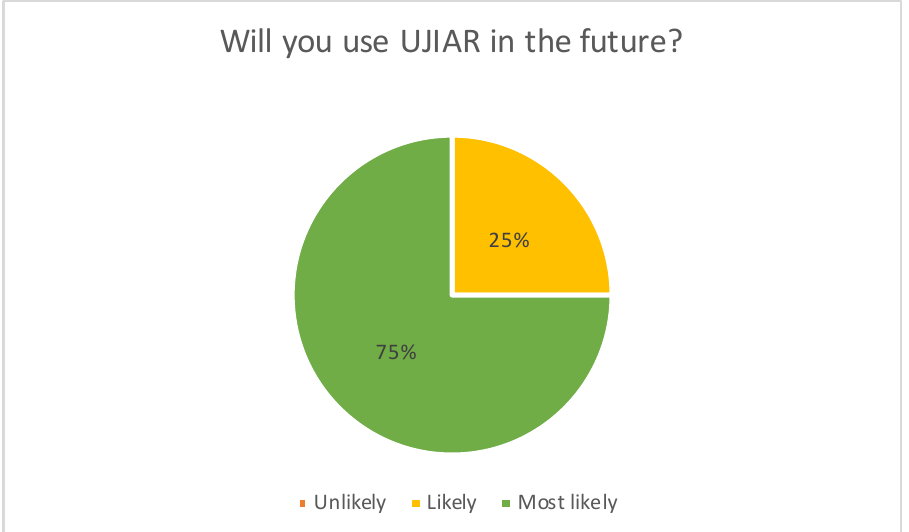
Figure 13. Preference of using the app in near future by the